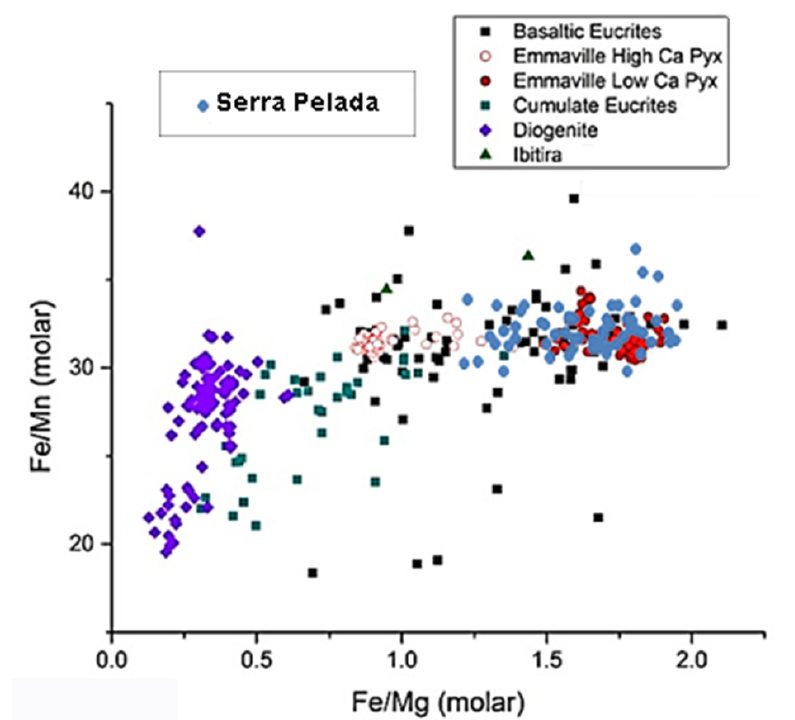
Figure 9 - Pyroxene Fe/Mg vs. Fe/Mn diagram. Basaltic eucrite, cumulate eucrite, diogenite and Ibitira data taken from Barret et al. (2015). Serra Pelada fits well within the low Ca basaltic